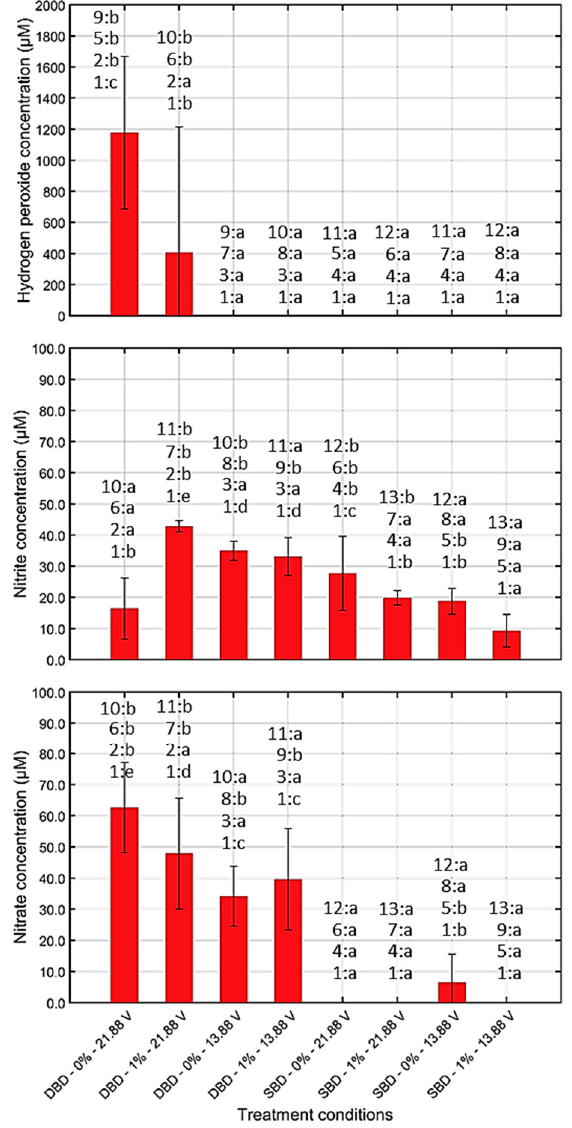
Figure 3. H 2 O 2 , nitrite, and nitrate concentrations ( µ M) obtained following CAP treatment of 500 µ L of sterile water using each possible combination of plasma characteristics ( n = 3). Significant di ff erences between all examined conditions (ANOVA test 1) have been indicated by means of a di ff erent small letter, with ‘a’ bearing the lowest value. The influence of the oxygen level (ANOVA tests 2–5), the electrode configuration (ANOVA tests 6–9), and the discharge power (ANOVA tests 10–13) on the chemical composition have been indicated as well by means of a di ff erent small letter, with ‘a’ again bearing the lowest value.